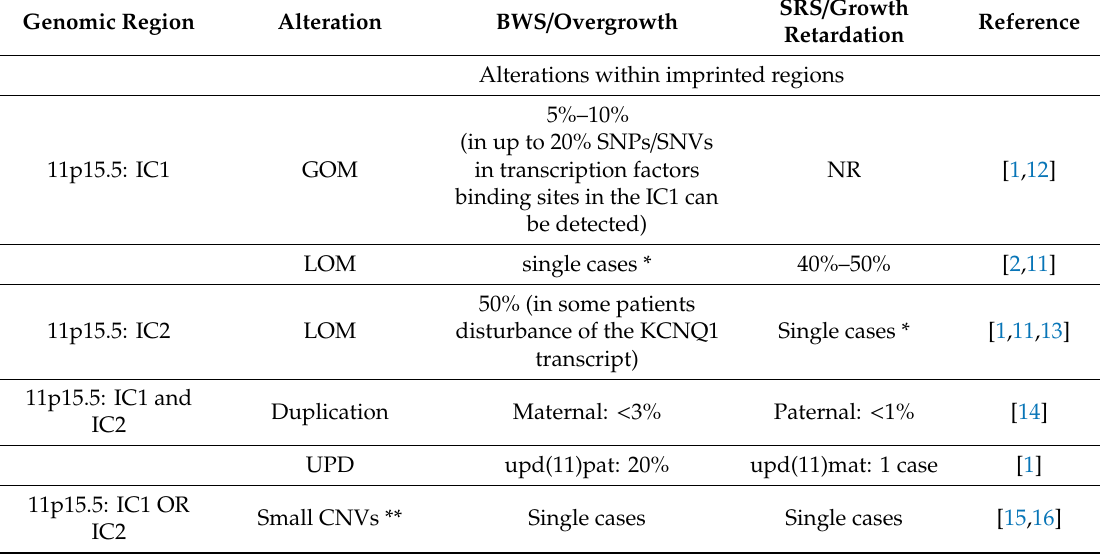
Table 1. Molecular findings in patients with Beckwith–Wiedemann syndrome (BWS) or Silver– Russell syndrome (SRS) features.